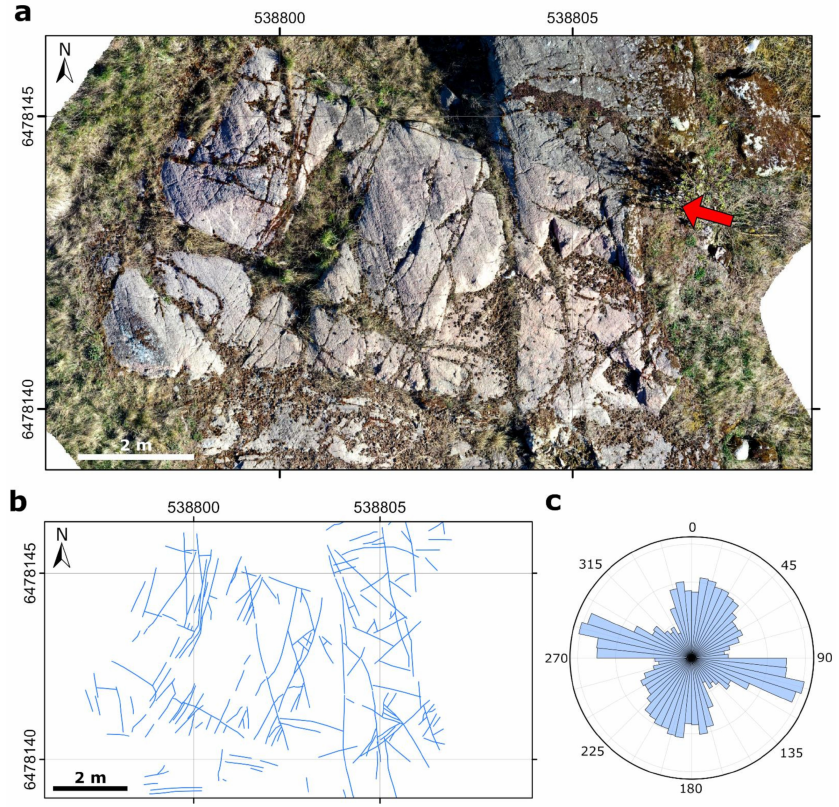
Figure 9. ( a ) Example section of a drone orthophoto of an outcrop within the study area. A contact between fine-grained granodiorite rocks (grey) and coarse-grained granite rocks (pink) is marked with a red arrow. ( b ) interpreted fractures (blue lines) for the portion of the orthophoto shown in ( a ). ( c ) Rose diagram showing the orientation of fractures mapped on all outcrops within the study area, where drone photographs were